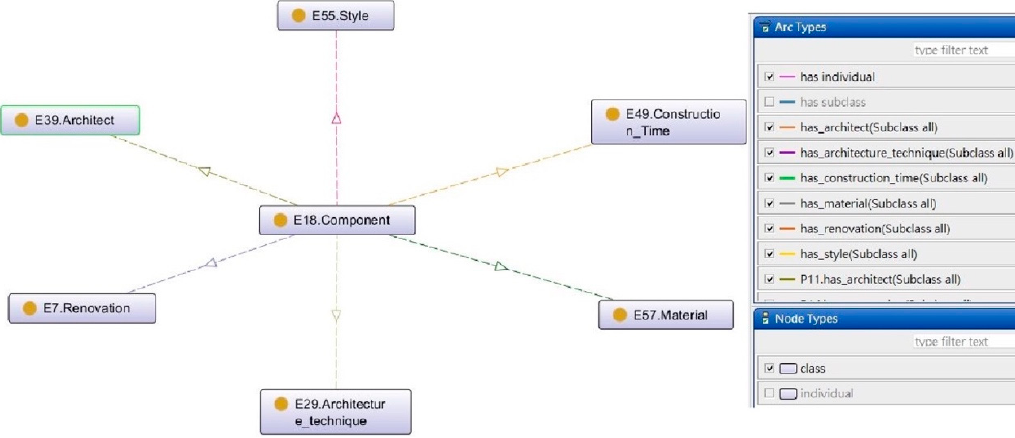
Figure 8. Object property of the ontological knowledge model.